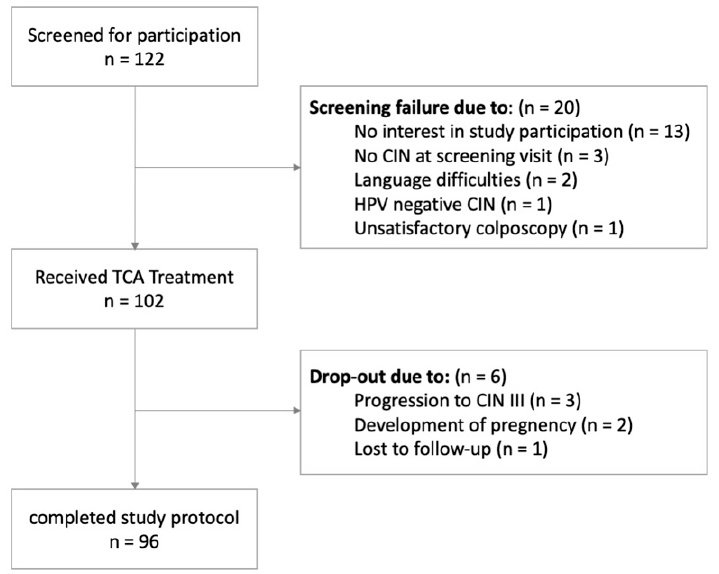
Figure 1. Consort diagram TCA 85% chloroacetic acid, CIN: cervical intraepithelial neoplasia. HPV human papilloma virus.